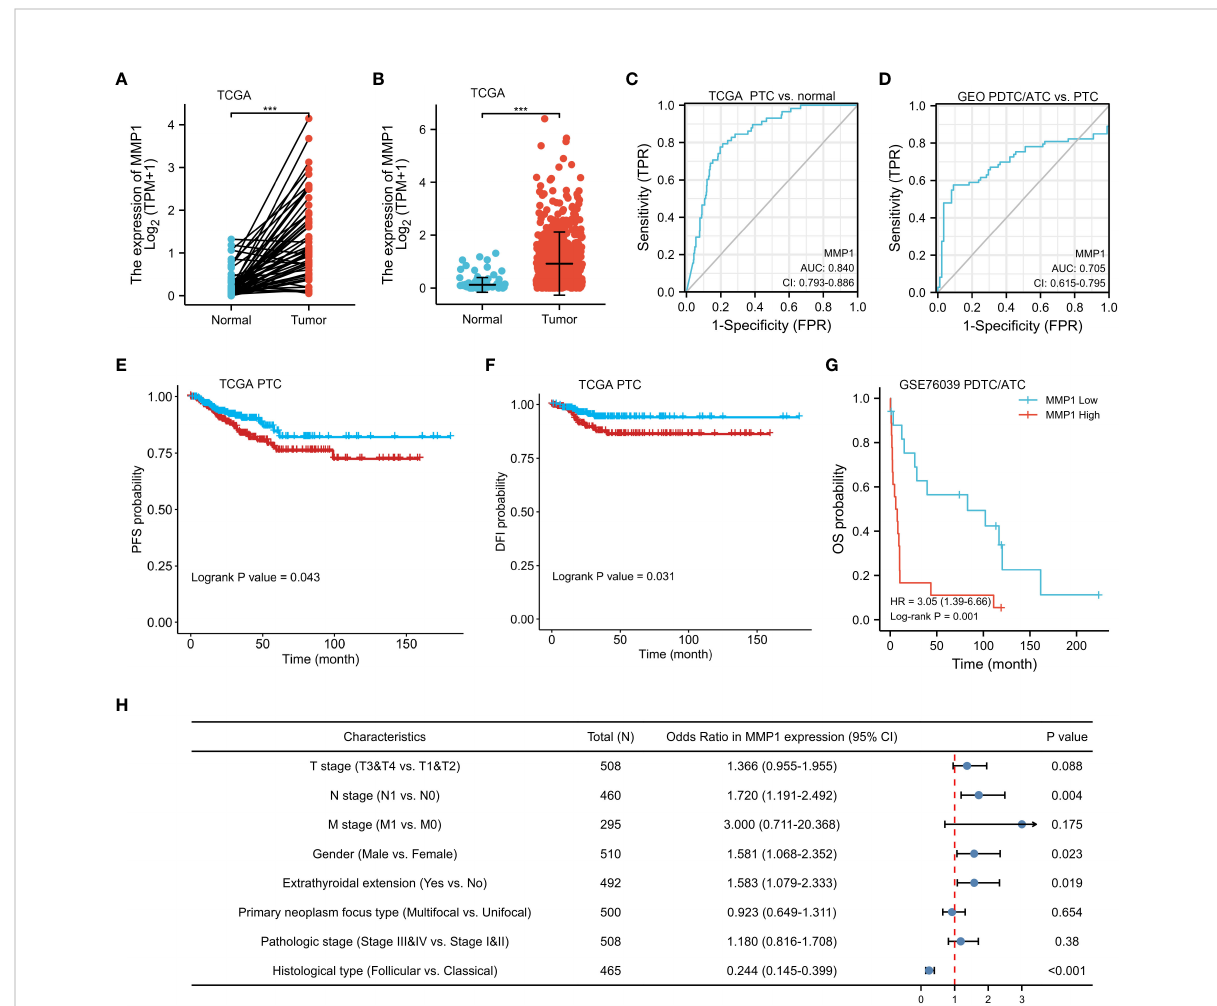
FIGURE 3 Clinical signi fi cance of MMP1 in PTC and PDTC/ATC. (A) The mRNA levels of MMP1 were up-regulated in PTC samples, which were downloaded from the TCGA database containing 58 paired PTC and normal tissue samples. (B) MMP1 was up-regulated in PTC samples, which were downloaded from the TCGA database containing 510 PTC samples and 58 normal tissue samples. (C) MMP1 effectively discriminated between PTC and normal tissues from the TCGA database. (D) MMP1 effectively discriminated between PDTC/ATC and PTC tissues from the GEO database. PTC patients with higher MMP1 levels harbor worse (E) PFS and (F) DFI. PDTC/ATC patients with higher MMP1 levels harbor worse (G) OS. (H) Forest plot of MMP1 in univariate logistic regression analyses of clinicopathological characteristics of the PTC patients from TCGA database. GEO, the Gene Expression Omnibus; PDTC, poorly differentiated thyroid cancer; ATC, anaplastic thyroid cancer; PTC, papillary thyroid cancer; TCGA, The Cancer Genome Atlas; AUC, the area under the curve; CI, con fi dence interval; vs., versus; HR, hazard ratio; PFS, progression-free survival; DFI, disease-free interval; OS, overall survival. ***P